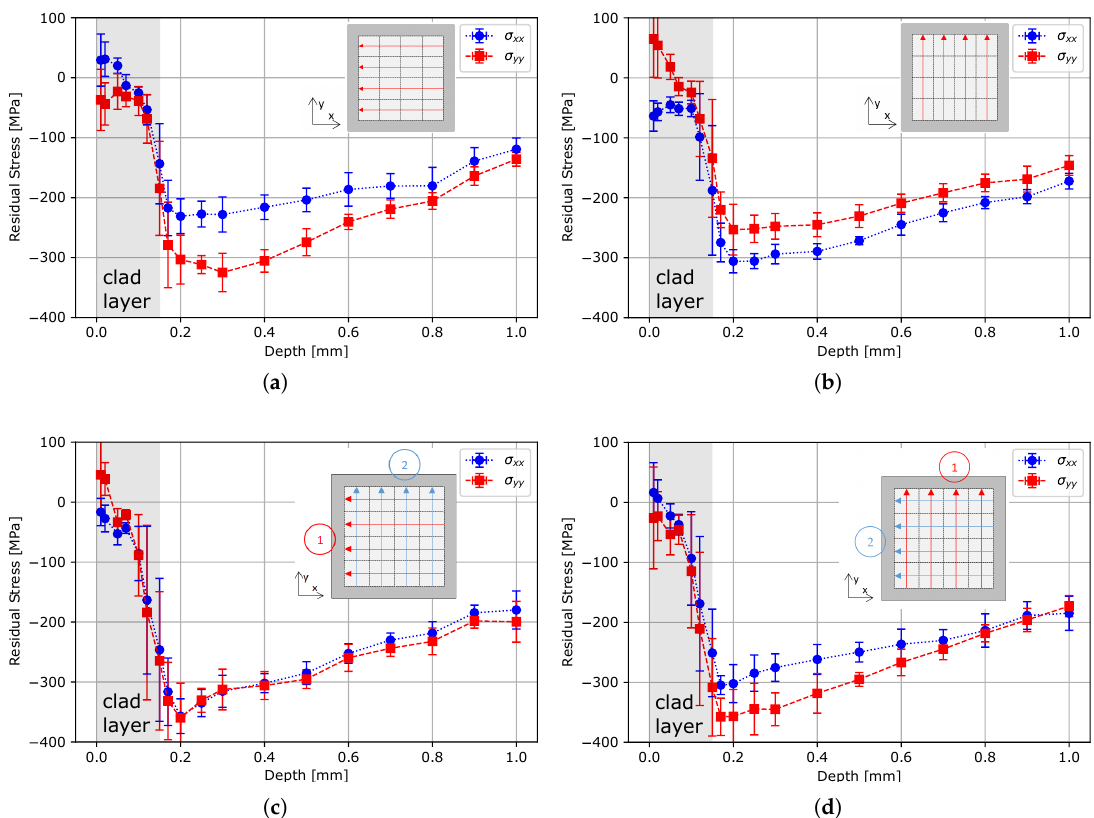
Figure 4. AA2024-T3clad: ( a ) one peening sequence with the LP advancing direction parallel to the rolling direction of the specimens; ( b ) one peening sequence with the LP advancing direction orthogonal to the rolling direction of the specimens; ( c ) two peening sequences with the first peening sequence advancing direction chosen parallel to the rolling direction and second peening sequence advancing direction chosen orthogonal to the rolling direction; ( d ) two peening sequences with the first peening sequence advancing direction chosen orthogonal to the rolling direction and the second peening sequence advancing direction chosen parallel to the rolling direction. The gray area indicates the clad layer.